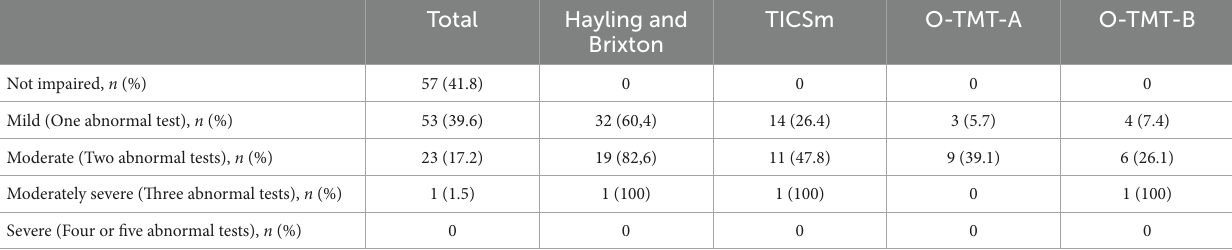
Total Hayling and Brixton